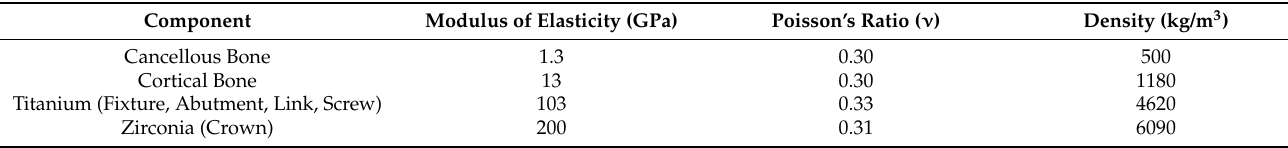
Table 2. Material properties used in the finite element analysis.